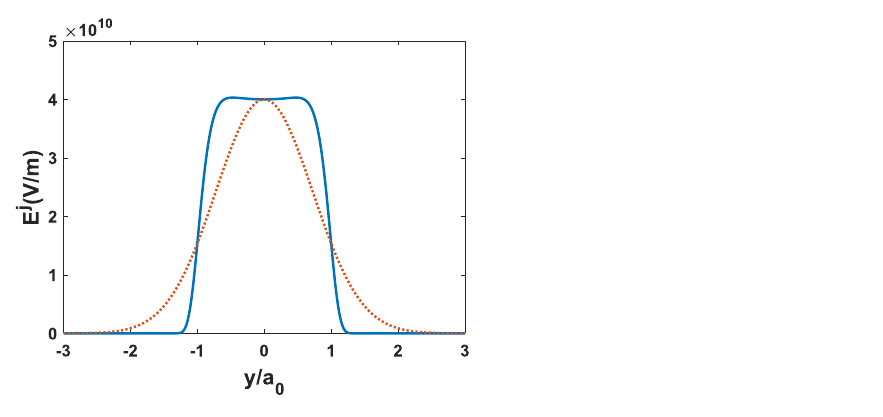
Figure 1. Solid thick line shows profile of a hat top beam, whereas the dotted line corresponds to the Gaussian beam.